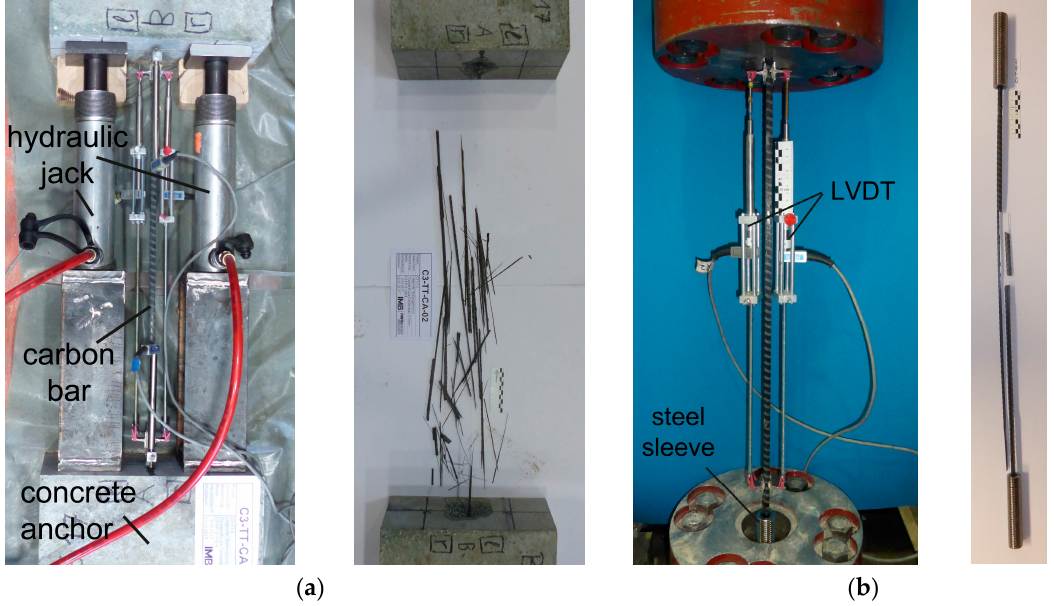
Figure 2. ( a ) Testing of carbon bars in uniaxial tension with concrete anchorage and ( b ) with adhesive anchorage in steel